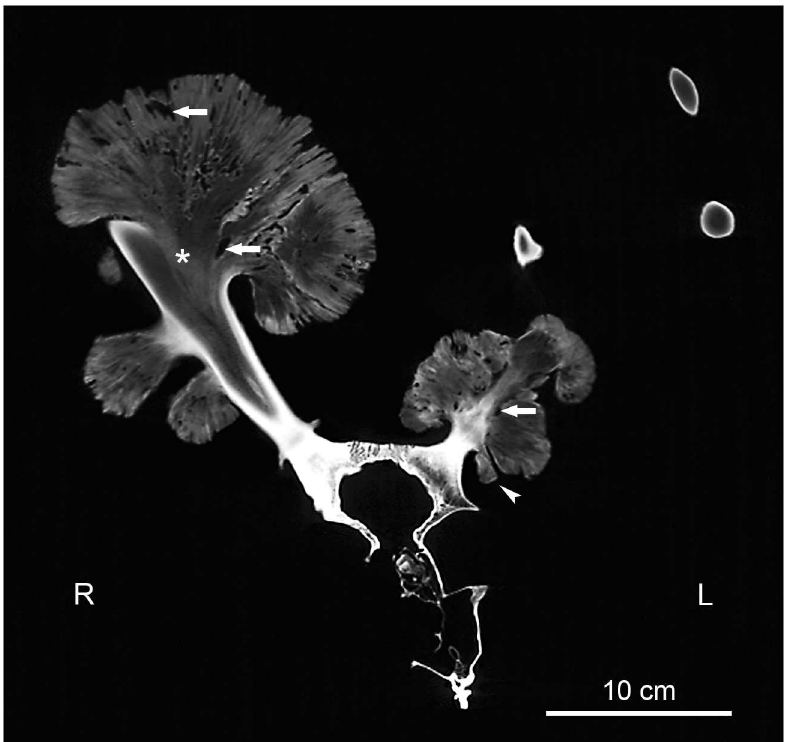
Fig 4. CT image showing the cranium and antlers of the white-tailed buck ( Odocoileus virginianus ). Note the normalcompositionof the antlers with a compact cortex and a cancellous core, as seen in the right antler and the two virtual cross sectionsof the distal part of the left antler in the upper right corner of the large image. Also note the continuityof the spongiosa(asterisk) and the cortex (present only in the basal stalk region)of the large exostosis from the right antler with the respectivecomponents of the parent bone. The seemingnon-continuity of the cancellous bone betweenthe antler and the smaller exostosis from the right antler as well as its seeminglybipartite structure is due to the fact that the slice is not locatedin the central axis of its stalk. Arrows: radiolucent areas within the outgrowths. R: right side; L: left side.